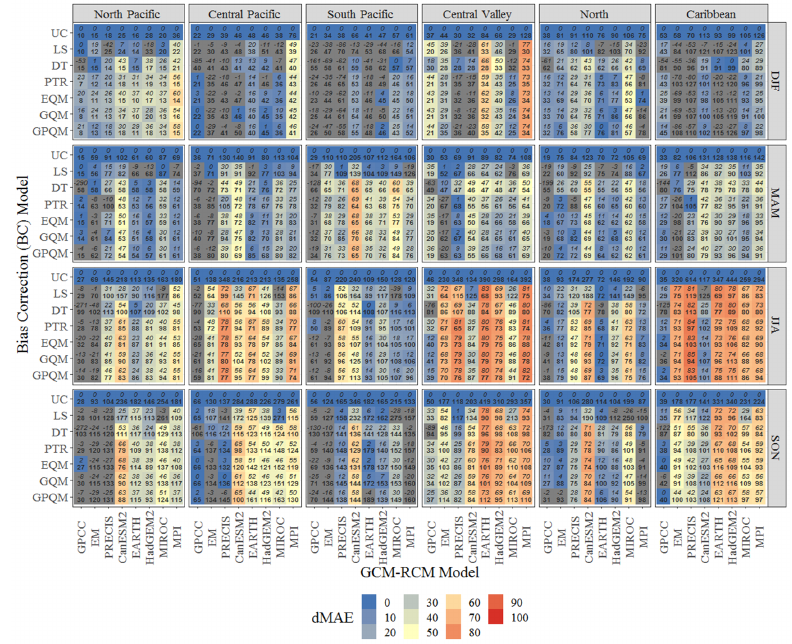
Figure 7. Spatially-averaged mean absolute deviation (MAE) performance of uncorrected and bias-corrected precipitation during the validation period 1981–1995 for all climatic regions of Costa Rica. Bold cell numbers represent absolute MAE values (mm/month), whereas italic numbers and scale-color represent the MAE relative percentage change (%) after bias correction. Negative values are presented in grey.